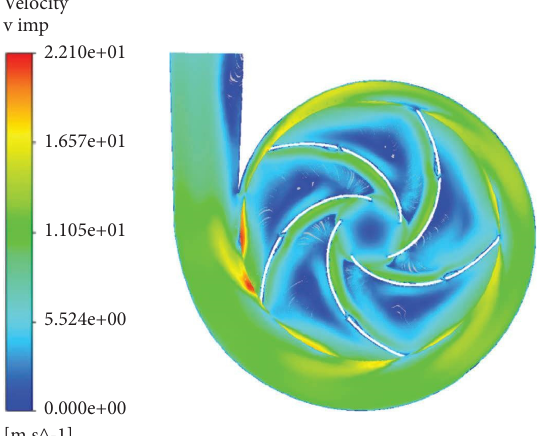
Figure 13: Optimized velocity